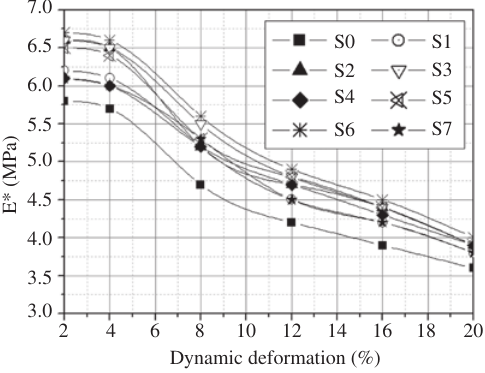
Figure 2 Dynamic mechanical properties: complex dynamic modulus (E*) of the studied composites as a function of dynamic deformation.